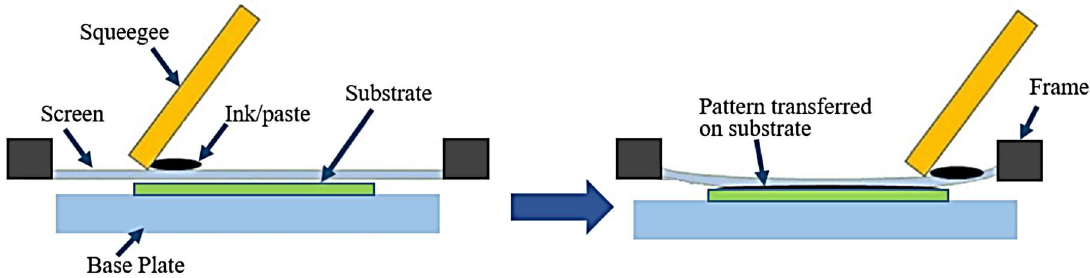
Figure 1. An illustration of a conventional screen printing process.